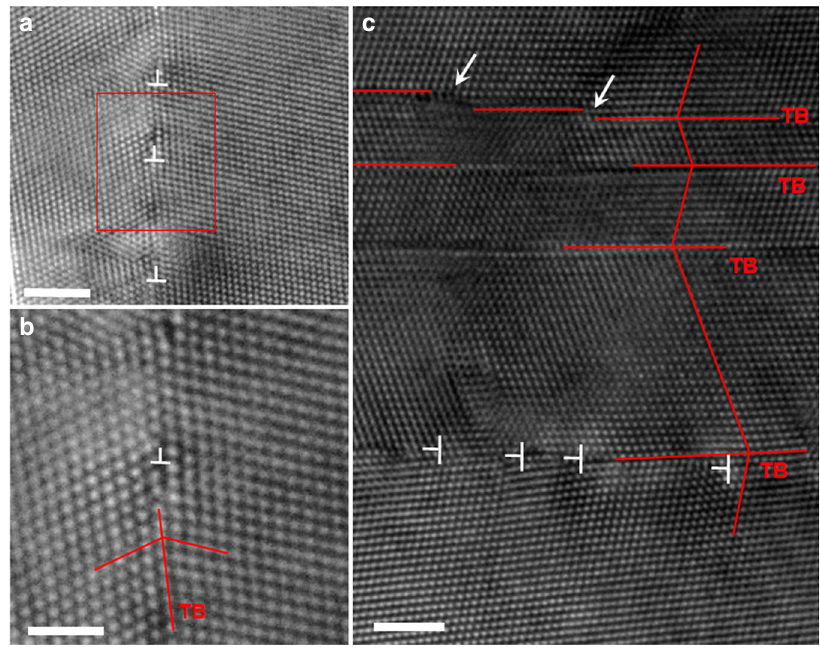
Fig. 2 The direct observation of switchover from partial dislocation in thinner twins to full dislocation in thick twins. a A typical HRTEM image showing several full dislocations that intersect with the TBs in relatively thick twins/matrixes (marked with T). b Enlarged HRTEM image corresponding to the red framed region of a . c In a grain that contains both relatively thin and thick twins/matrixes, several full dislocations glide on the planes that intersect with the TBs and are blocked by the TBs, and several steps resulting from partial dislocations are directly detected in relatively thin twins/matrixes. The scale bars are 2 nm, 1 nm and 2 nm for a , b and c ,